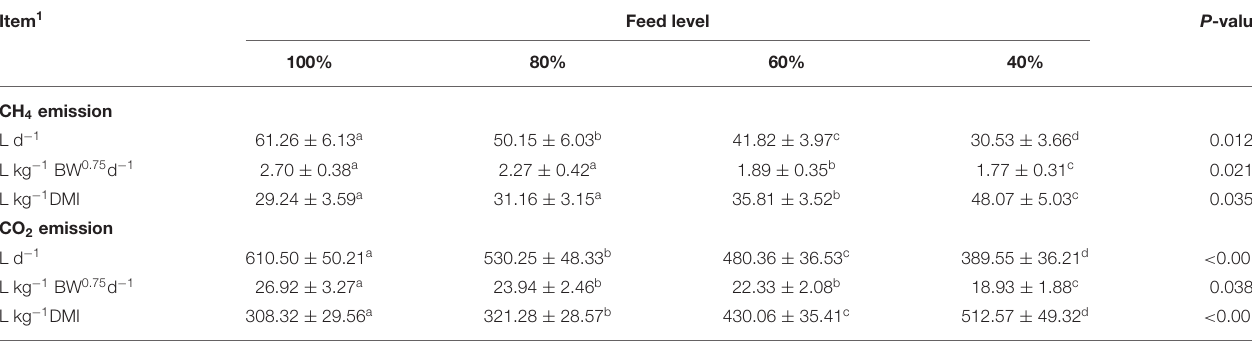
TABLE 3 | Effect of feed intake on daily methane (CH 4 ) and carbon dioxide (CO 2 )